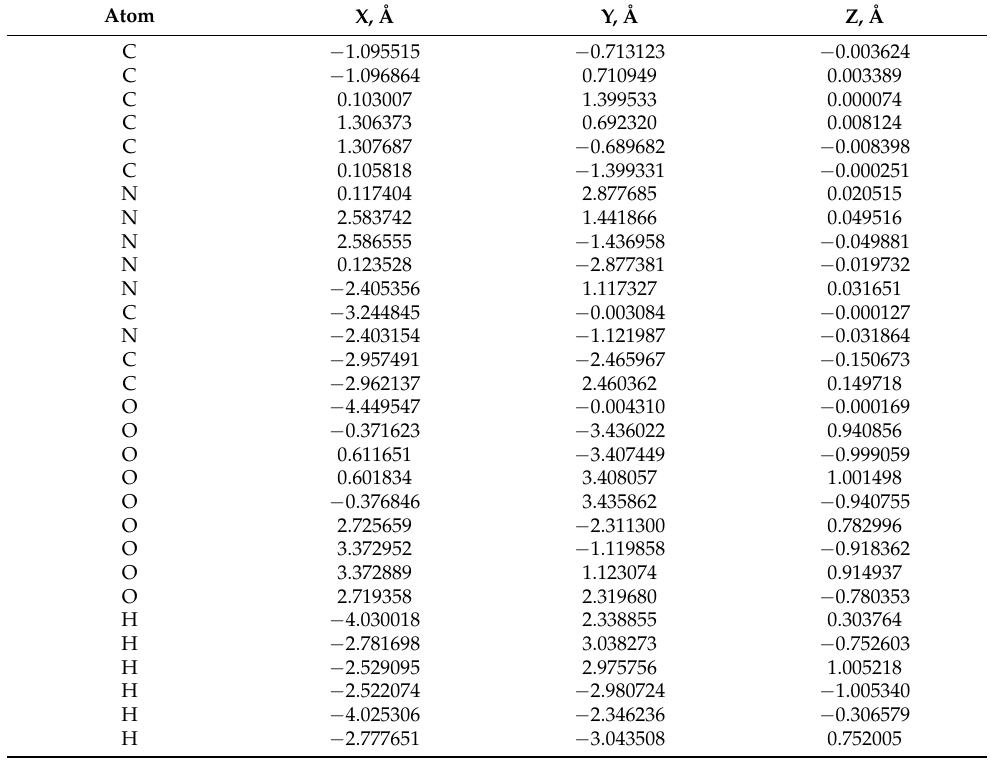
Table A6. Convergent geometries of E-VI.